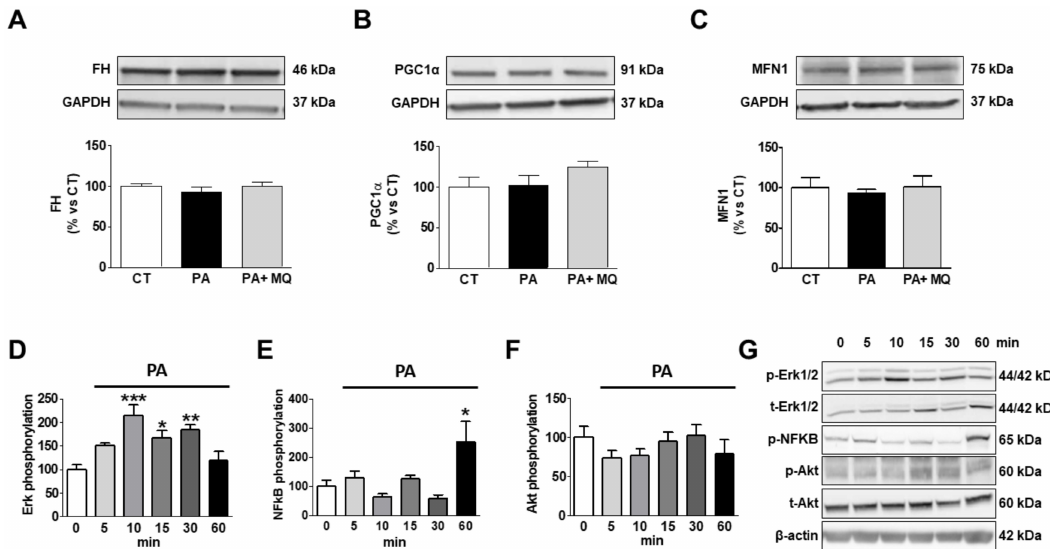
Figure 8. E ff ects of antioxidant MitoQ (MQ) on protein levels in palmitic acid (PA)-treated H9c2 cells. Protein levels of ( A ) fumarate hydratase (FH), ( B ) peroxisome proliferator-activated receptor gamma coactivator 1-alpha (PGC-1 α ), ( C ) mitofusin 1 (MFN1) in cardiac myoblasts treated for 24 h with PA (200 µ M) in the presence of absence of the mitochondrial antioxidant MitoQ (MQ; 5 nM). ( D ) Phosphorylated protein of extracellular signal-regulated kinases (pErk1 / 2), ( E ) phosphorylated protein of nuclear factor- κ B p65 (pNF- κ B), and ( F ) phosphorylated protein kinase B (pAkt) in cardiac myoblasts treated with PA (200 µ M) at di ff erent times. ( G ) Representative images blots for phosphorylation of intracellular signaling pathways. Bar graphs represent the mean ± SEM of four to six assays normalized to glyceraldehyde-3-phosphate dehydrogenase ( A – C ), β -actin, ( E ) or total Erk1 / 2 ( D ) and total Akt ( F ). * p < 0.05; ** p < 0.01; *** p < 0.001 vs. control